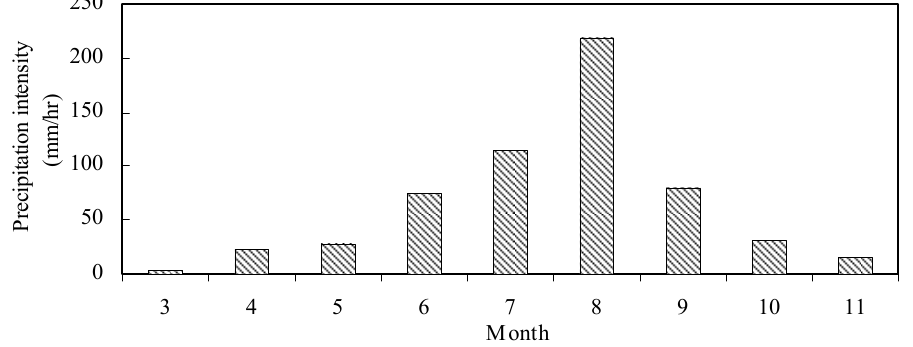
Figure 4. Distribution characteristics of rainfall intensity in test area (Data from the weather station in the test area, 2017).